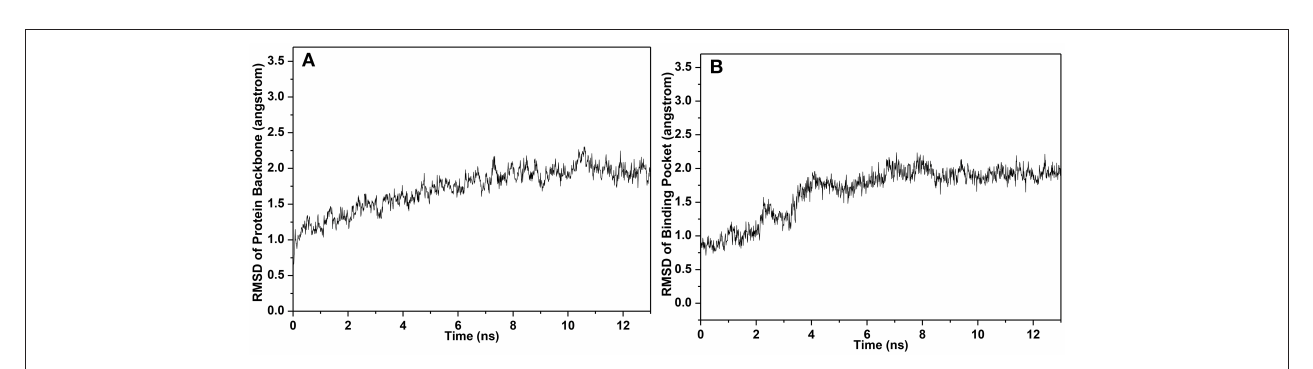
FIGURE 8 | RMSD of (A) protein backbone and (B) binding